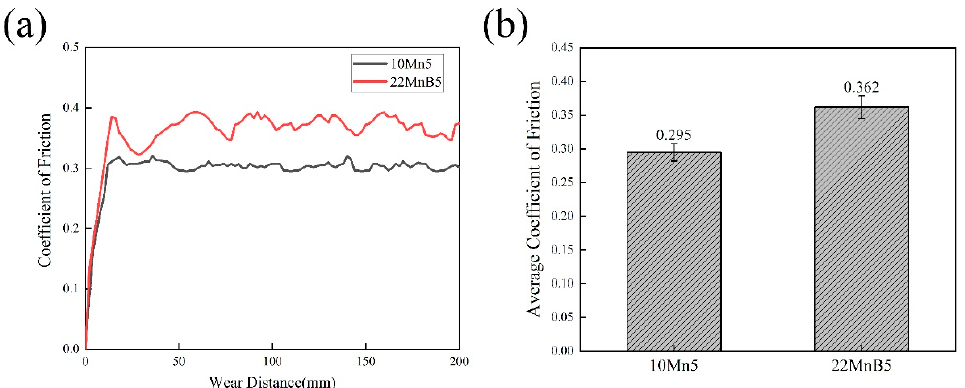
Figure 3. Friction coefficients of 22MnB5 and 10Mn5 at the high-temperature friction test, ( a ) Friction coefficient as a function of sliding distance; ( b ) Average Friction coefficient.